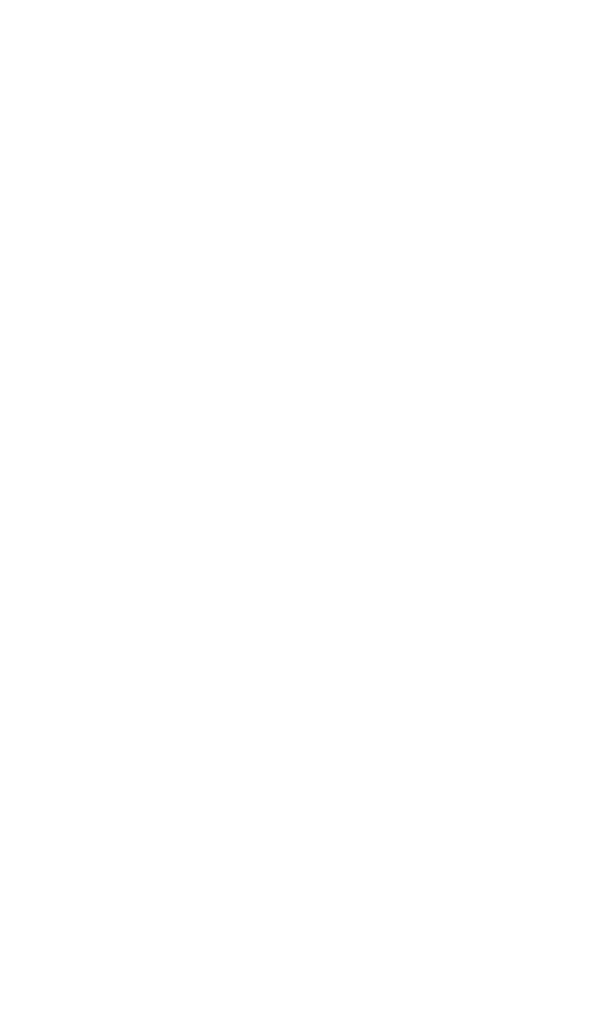
FIGUREA3 | MS 2 555.3 spectrum by collisional activation of the doubly charged molecular ion from synthetic